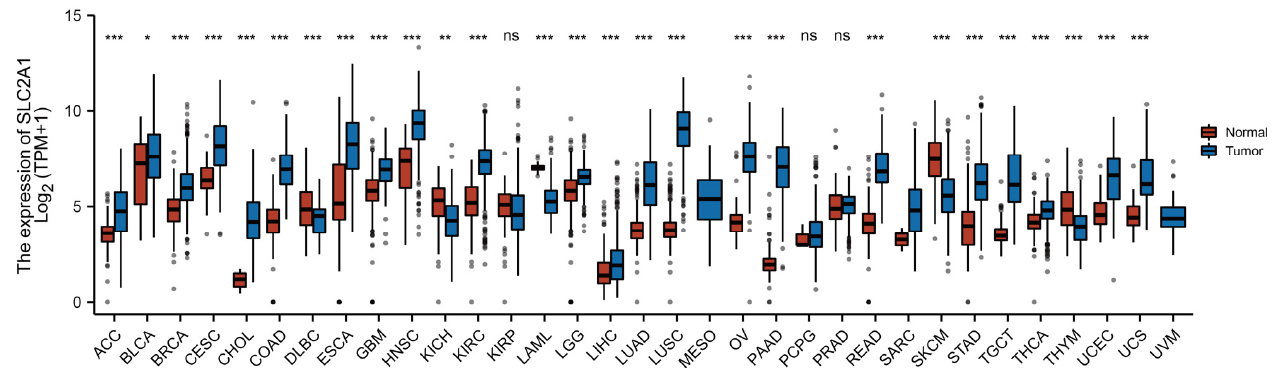
Figure 1. SLC2A1 expression in pan-cancer. ACC, adrenocortical carcinoma; BLCA, bladder urothe- lial carcinoma; BRCA, breast invasive carcinoma; CESC, cervical squamous cell carcinoma and endocervical adenocarcinoma; CHOL, cholangiocarcinoma; COAD, colon adenocarcinoma; DLBC, lymphoid neoplasm diffuse large B-cell lymphoma; ESCA, esophageal carcinoma; GBM, glioblas- toma multiforme; HNSC, head and neck squamous cell carcinoma; KICH, kidney chromophobe; KIRC, kidney renal clear cell carcinoma; KIRP, kidney renal papillary cell carcinoma; LAML, acute myeloid leukemia; LGG, brain lower grade glioma; LIHC, liver hepatocellular carcinoma; LUAD, lung adenocarcinoma; LUSC, lung squamous cell carcinoma; MESO, mesothelioma; OV, ovarian serous cystadenocarcinoma; PAAD, pancreatic adenocarcinoma; PCPG, pheochromocytoma and paraganglioma; PRAD, prostate adenocarcinoma; READ rectum adenocarcinoma; SARC, sarcoma; SKCM, skin cutaneous melanoma; STAD, stomach adenocarcinoma; TGCT, testicular germ cell tumor; THCA, thyroid carcinoma; THYM, Thymoma; UCEC, uterine corpus endometrial carcinoma; UCS, uterine carcinosarcoma; UVM uveal melanoma(ns, p ≥ 0.05; *, p < 0.05; **, p < 0.01; ***, p < 0.001).